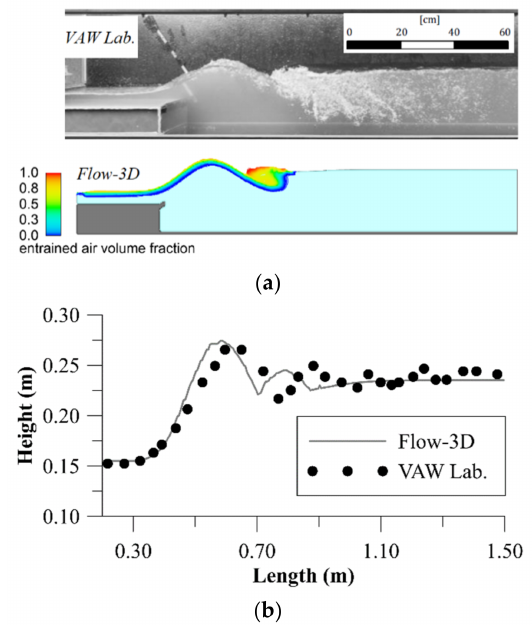
Figure 4. Calibration of the numerical model with laboratory data: ( a ) physical versus numeri- cal simulated wave (images are at the same scale—physical model photo courtesy of Koch [24]), ( b ) comparison of water surface